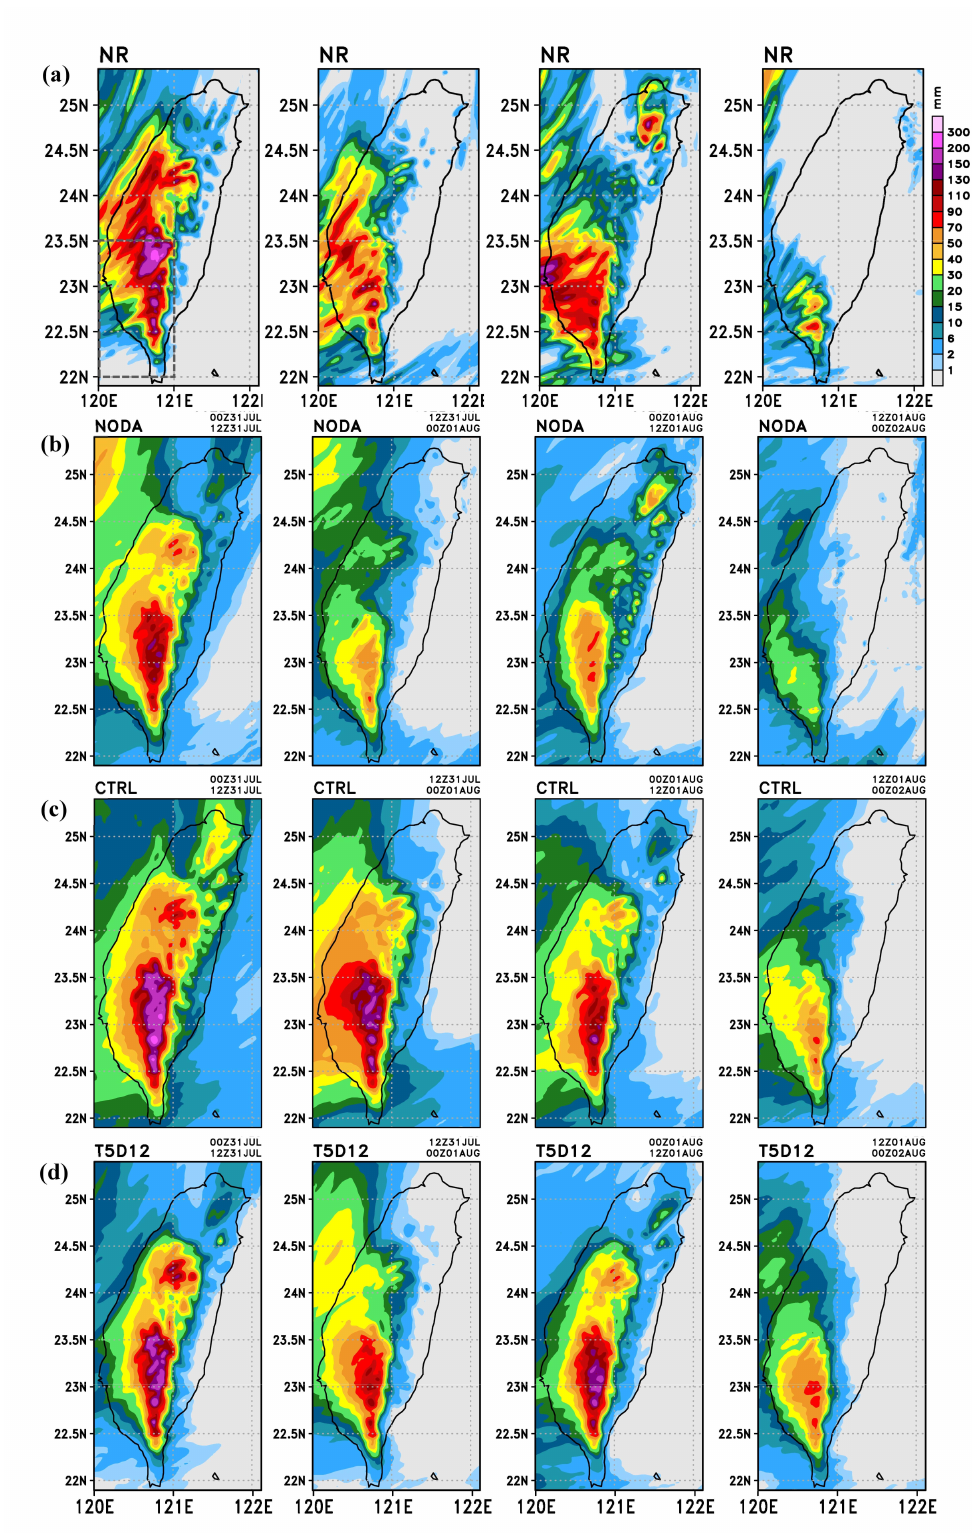
Figure 4. Same as Figure 1b but for ( a ) NR, ( b ) NODA, ( c ) CTRL, and ( d ) T5D12. Rain in ( b – d ) is obtained from the mean of 32 ensemble members. The gray dashed box in the leftmost panel of ( a ) denotes the area for the box-averaged rain intensity shown in Figure